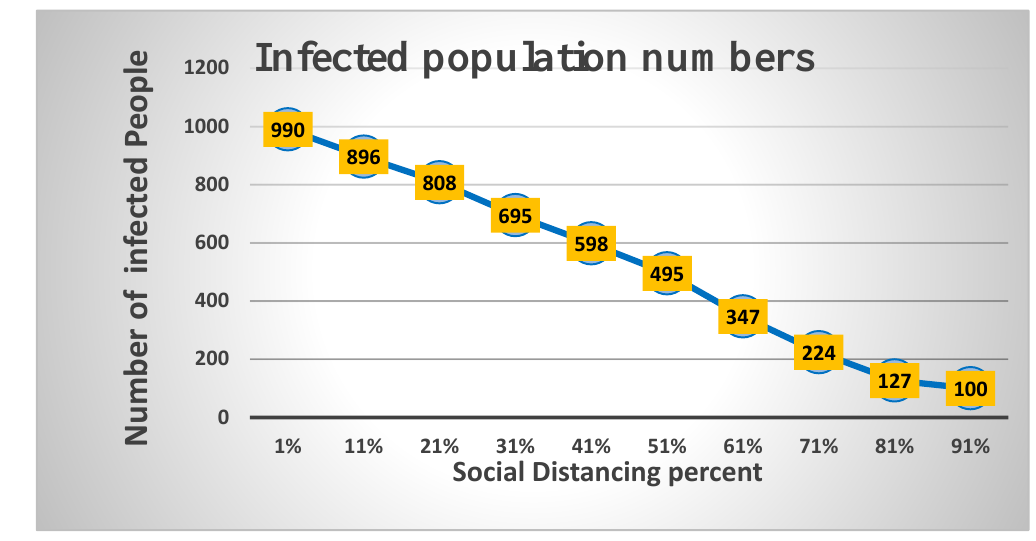
14 of 18 Figure 16. The final visual outputs of applying different levels of social distancing (with tracing individuals’ movement). Furthermore, additional experiments were conducted with ten varying levels of so-